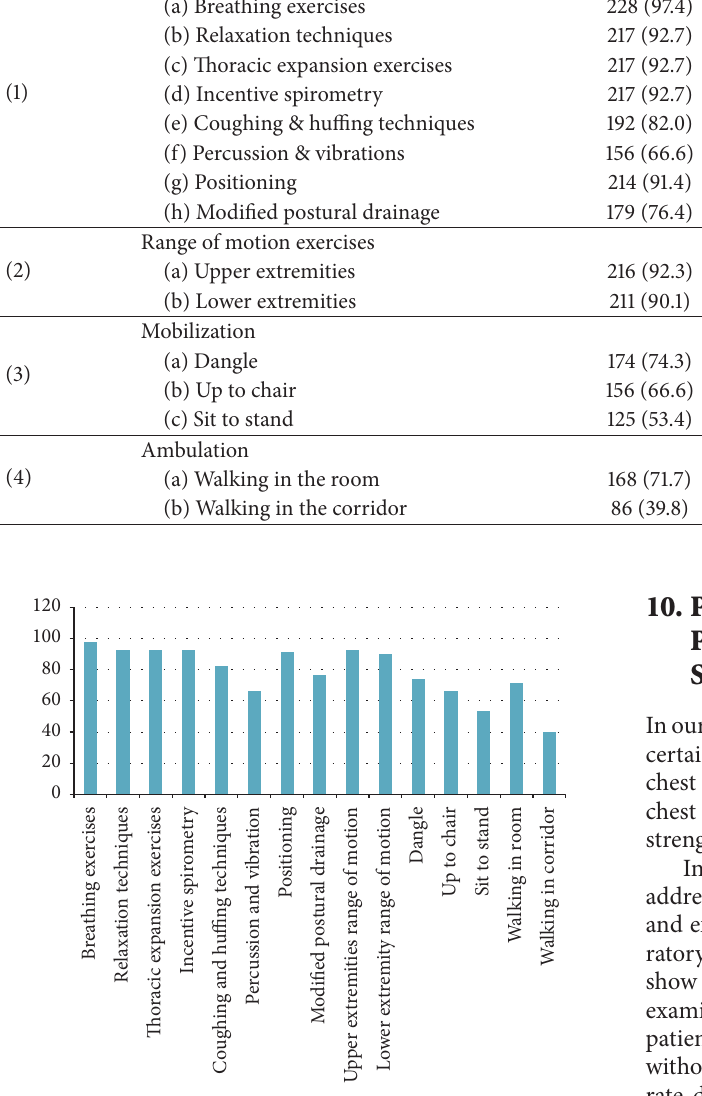
Figure 6: Physiotherapy interventions used on the 2nd postopera- tive